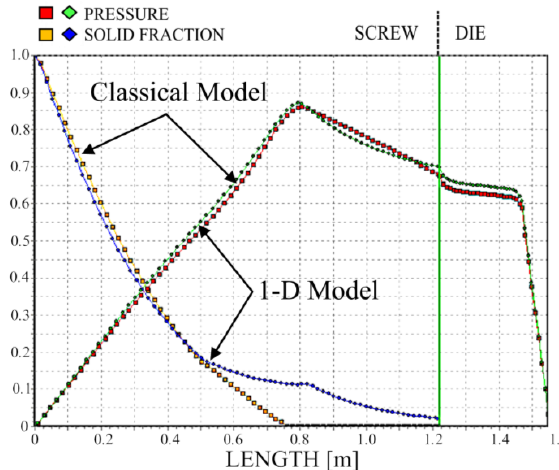
Figure 12. Solid bed profile and pressure profile for 1-D and 2-D simulations, N = 50 rpm.